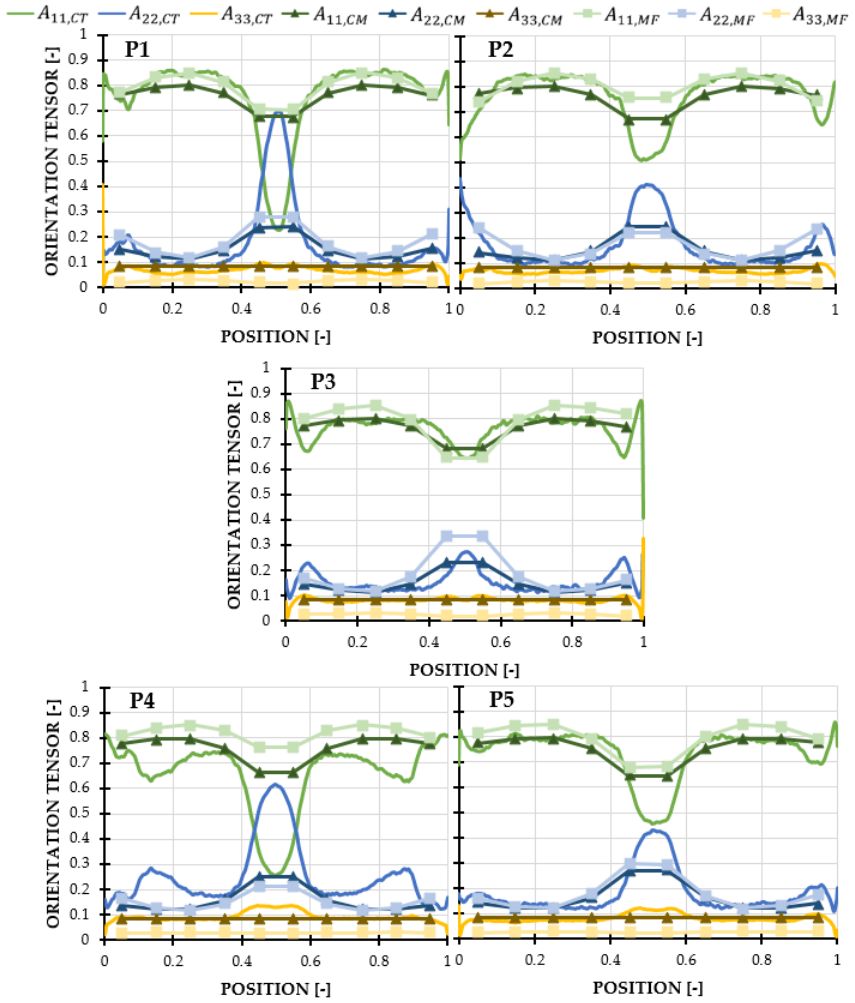
Figure 7. Experimental (CT) and simulative (CM, MF) components of the fiber orientation tensor A ij plotted over normalized position for PA66GF50 at plate level (P1–P5). Table 1. Relative deviation of the averaged orientation tensors from experiment A ij , CT and